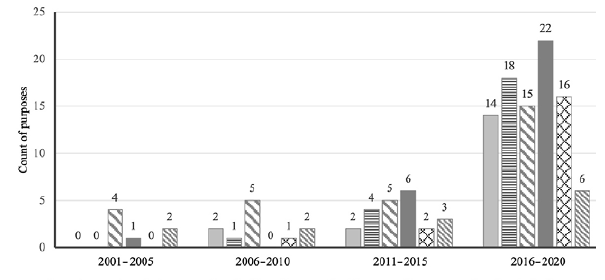
Figure 1. Distribution of purposes of the literature review studies